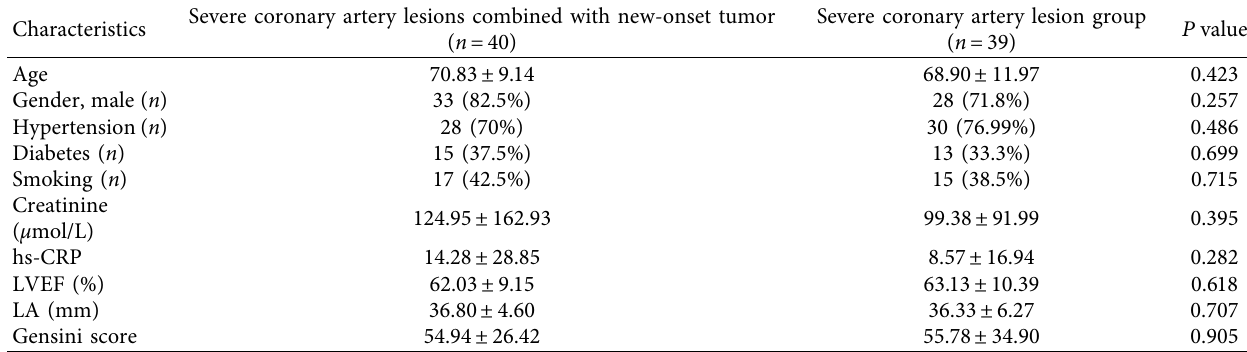
Table 1: Baseline demographic characteristics.